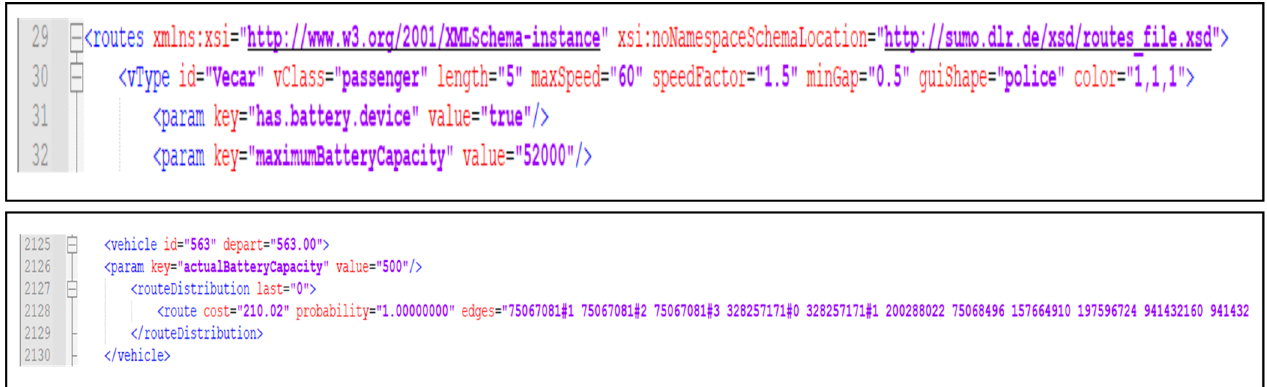
Figure 4. Configuration file and running the network.